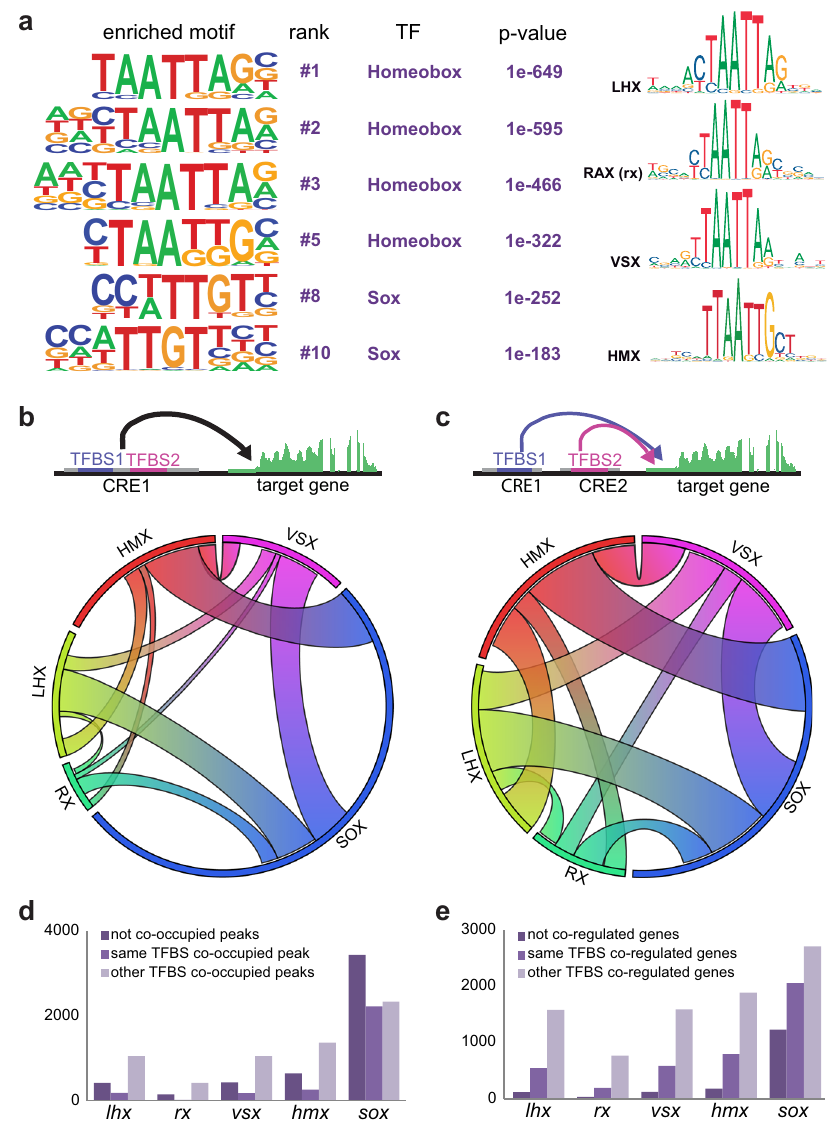
Fig. 4 NR motif enrichment analysis. a Representative TF binding motifs enriched in NR DOCRs as identi fi ed by HOMER. The binding motif similarity among neural retina TFs of the homeobox family is indicated (http://jaspar.genereg.net). b Circoplot illustrating the co-occupancy rate of TFBS in the same DOCRs for the main TFs identi fi ed in the motif enrichment analysis. c Circoplot illustrating the degree of co-regulation between TFs regulating the same gene through different DOCRs. d Number of CREs containing the main TFs identi fi ed in the motif enrichment analysis classi fi ed according to their co- occupancy. e Number of genes associated with CREs containing the main TFs identi fi ed in the motif enrichment analysis, classi fi ed according to their co-